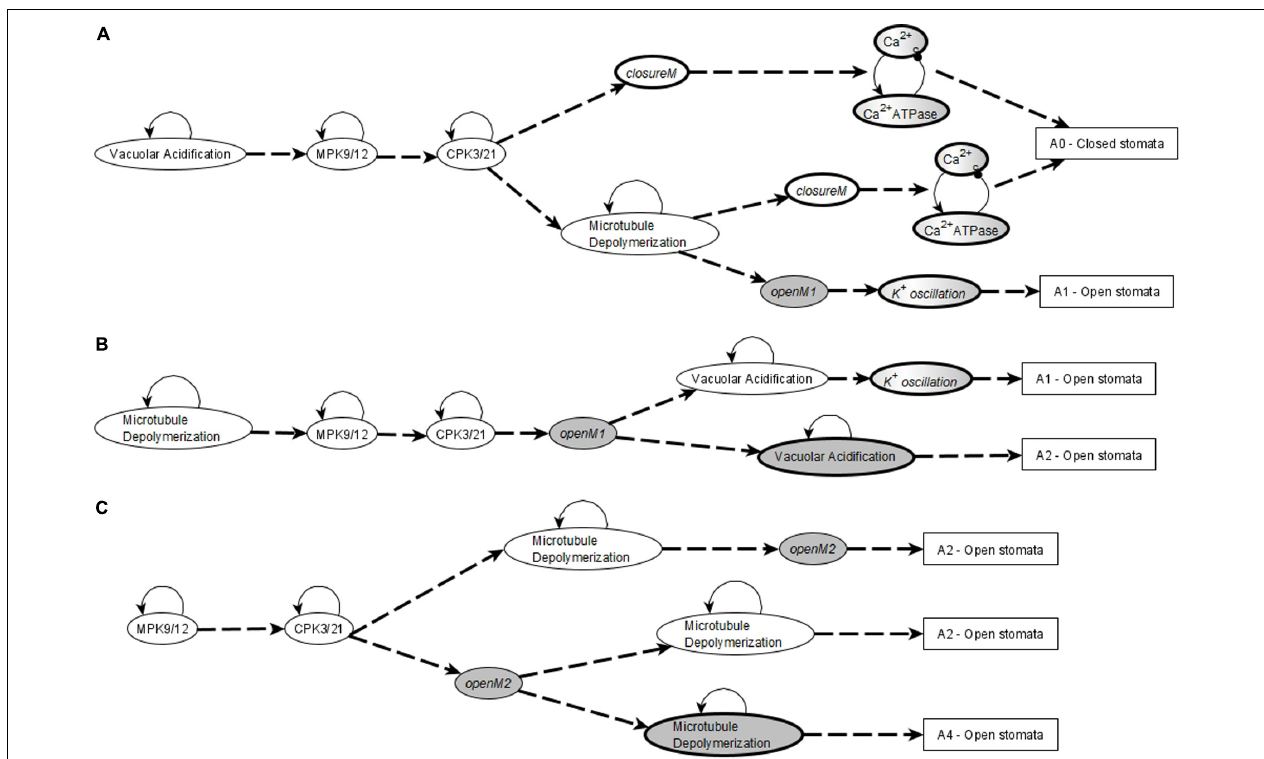
FIGURE 3 | Motif succession diagrams of Model1 in the absence of ABA and any other closure signal. Stable motifs are shown with oval symbols and attractors are indicated by rectangles. Each dashed directed line between two motifs indicates that the system states in which the first motif has established and any nodes driven by it have stabilized admit the second motif as next to activate. The dashed directed line converging into an attractor symbol indicates that the succession of stable motifs ensures the system’s convergence into the respective attractor. (A) shows a subset of the succession diagram that converges to the attractor A0, corresponding to closure of the stomata in the absence of ABA (see Supplementary Table S4 ). The stable motif characteristic to this attractor is the conditionally stable motif closureM . (B,C) show a subset of the succession diagram corresponding to a sample of the 16 attractors that describe open stomata in the absence of ABA (see Supplementary Table S4 ). Each possible trajectory in this case contains exactly one of the stable motifs openM1 and openM2 . (B) describes some of the trajectories containing openM1 while C describes some of the trajectories containing openM2. (A) also indicates the existence of bifurcations in the system’s trajectory due to the mutually exclusive motifs closureM and openM1. If closureM stabilizes the system converges into the attractor A0, and if openM1 stabilizes the system converges into attractor A1. The diagram encodes node states into the background color of the stable motif symbols. When referring to single nodes, white background indicates the ON state of the node, gray background means the OFF state of the node, and gray-white background represents oscillating nodes. Since in the openM1 and openM2 stable motifs all nodes are OFF (see Figure 2 ), we use a gray background color for these stable motifs. We use white background to represent the locking in of the closureM motif and represent the oscillating nature of the K + oscillation motif by a gray-white background. The conditionally stable motifs are marked by thick